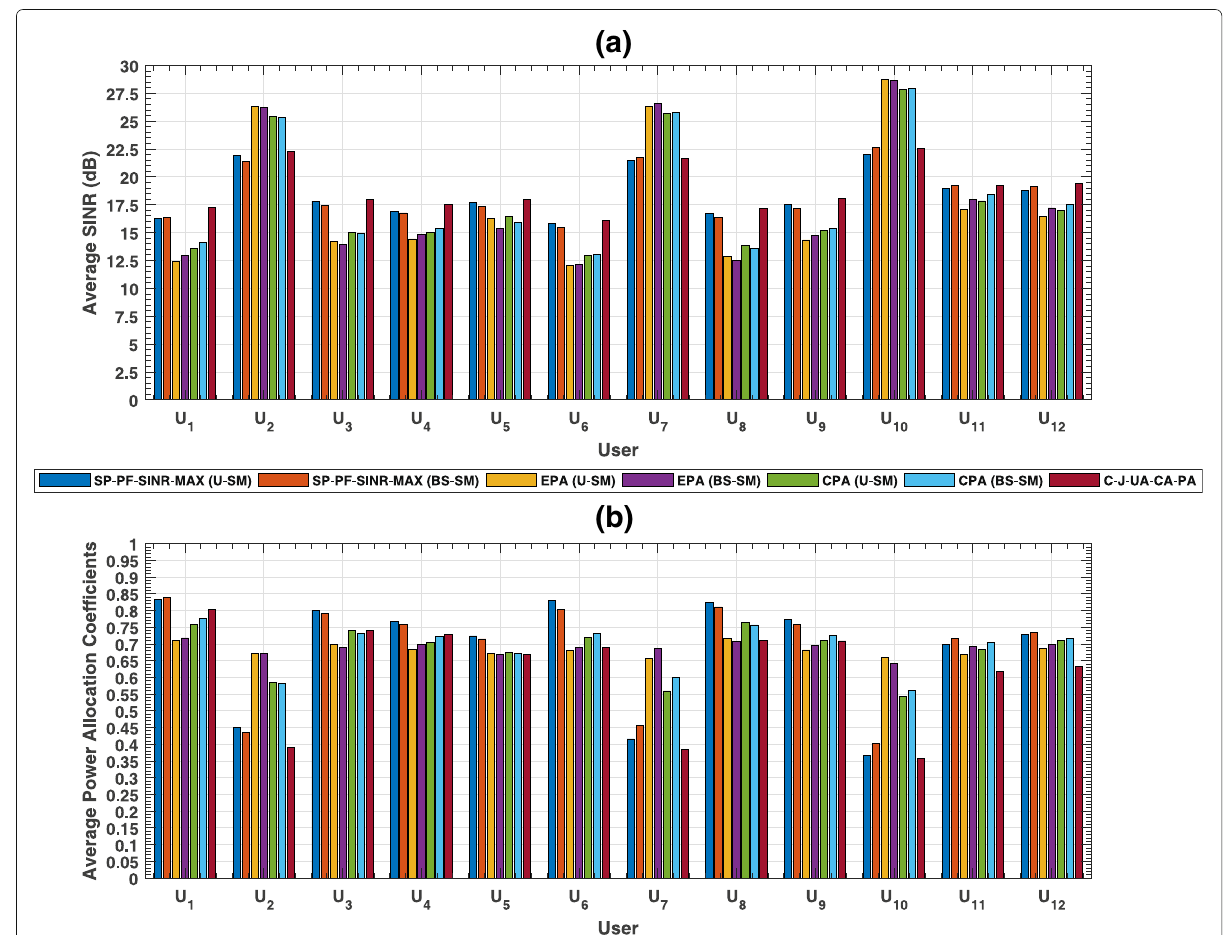
Fig. 3 a Average SINR (dB) and b average power allocation coefficients—Scenario